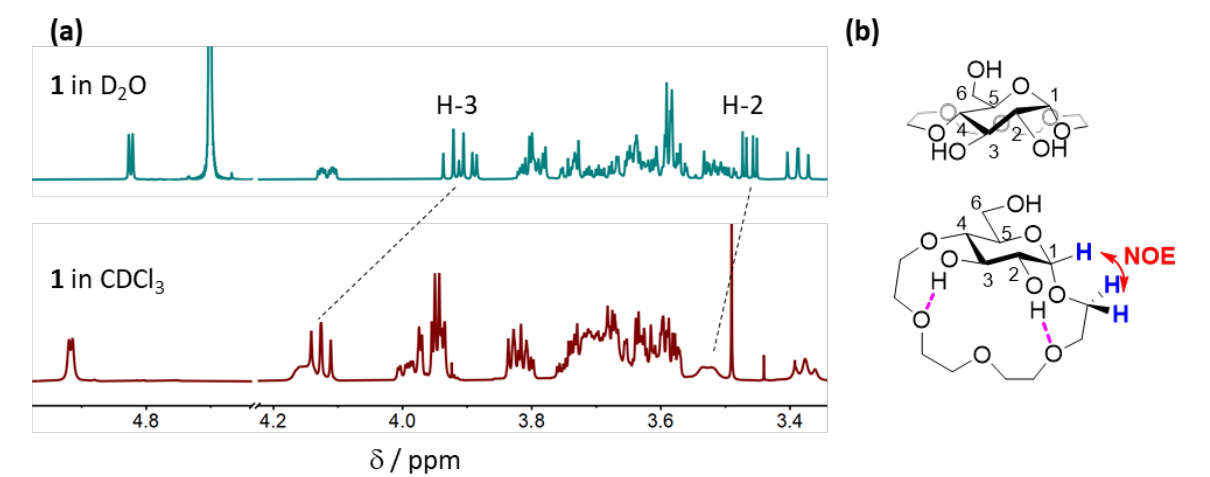
Figure 3. ( a ) 1 H NMR spectra of 1 in D 2 O (top) and in CDCl 3 (bottom). ( b ) Proposed conformation of 1 in D 2 O (top) and in CDCl 3 (bottom)—H atoms involved in through space interactions are shown in blue, the interaction is indicated in red, and proposed intramolecular H-bonds are shown in purple.